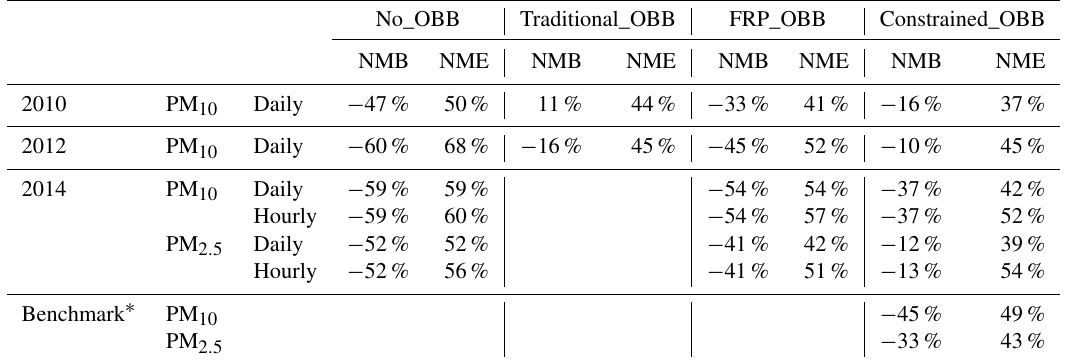
∗ From Zhang et al. (2006). NMB and NME were calculated using the following equations ( P and O indicate the results from modeling prediction and